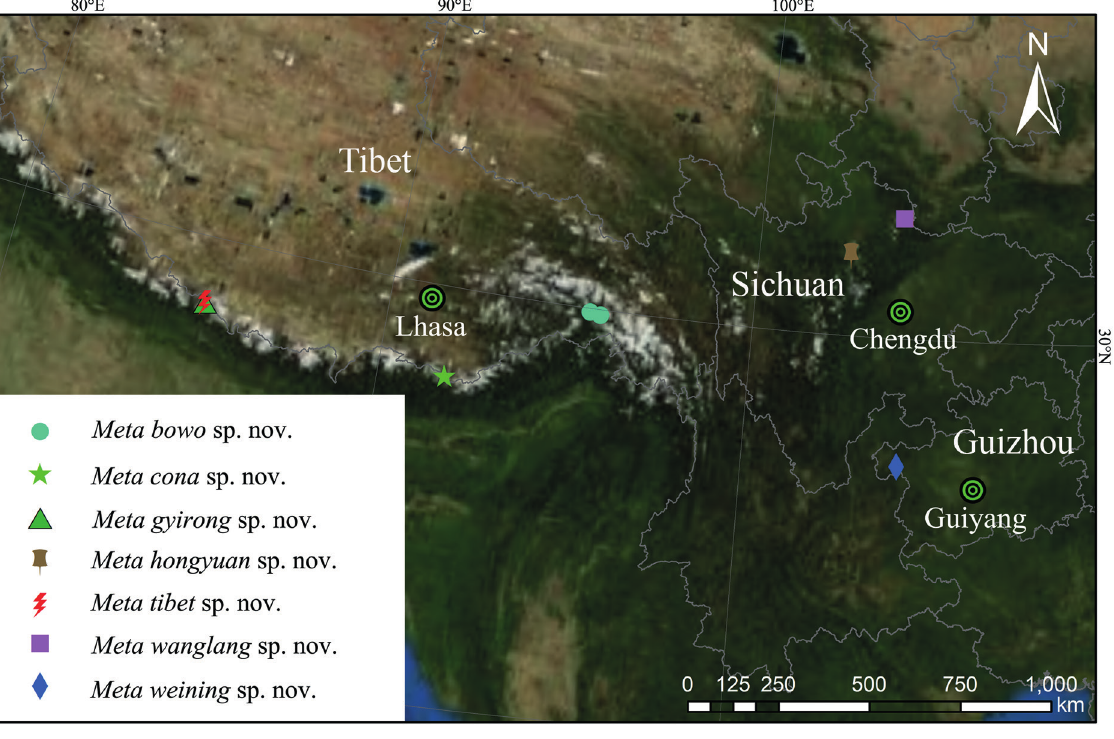
Fig. 22. Distribution records of seven new species of the genus Meta C.L. Koch, 1836 in Southwest